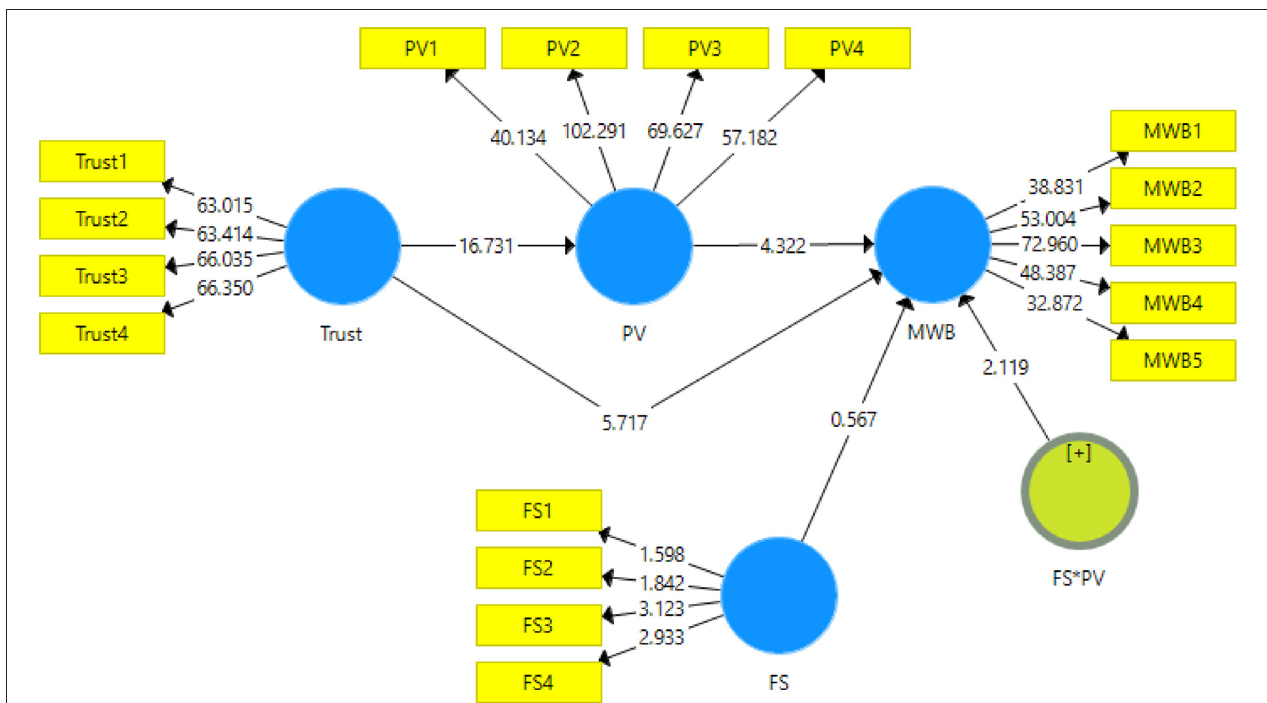
FIGURE 3 | Output of structural model. Trust, Trust in wellbeing information; PV, Preventive behavior; MWB, Mental wellbeing; FS, Family Support; FS*PV, Moderating effect of family support.